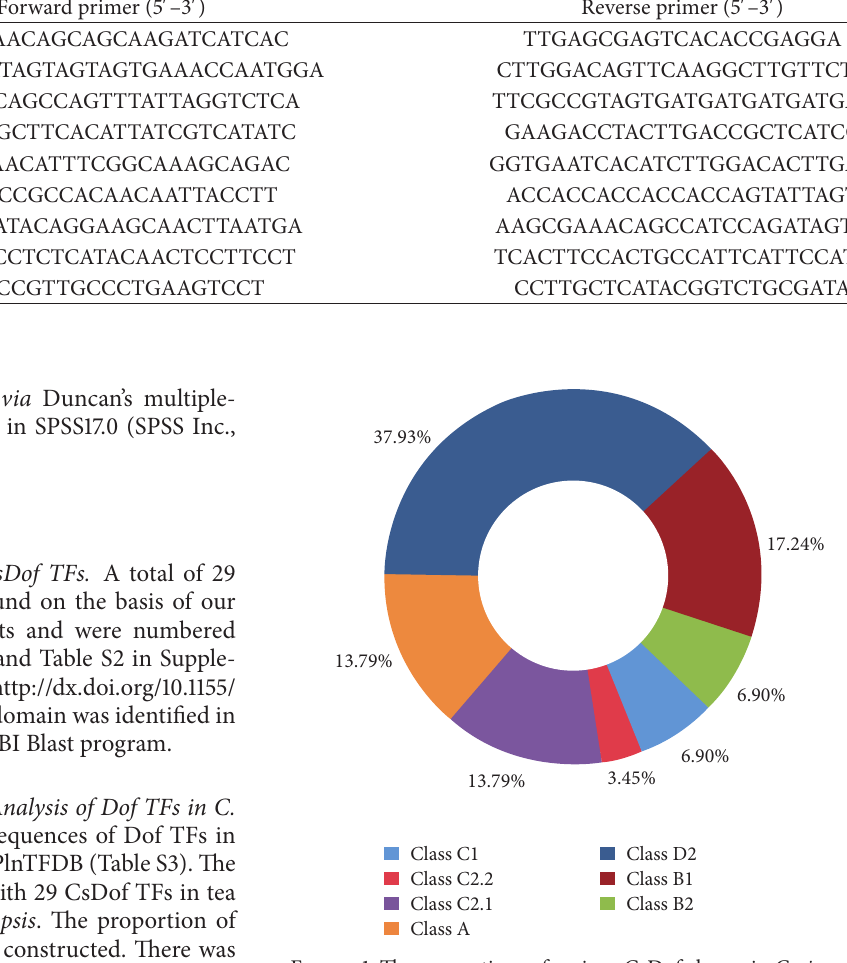
Figure 1: The proportions of various CsDof classes in C. sinensis .